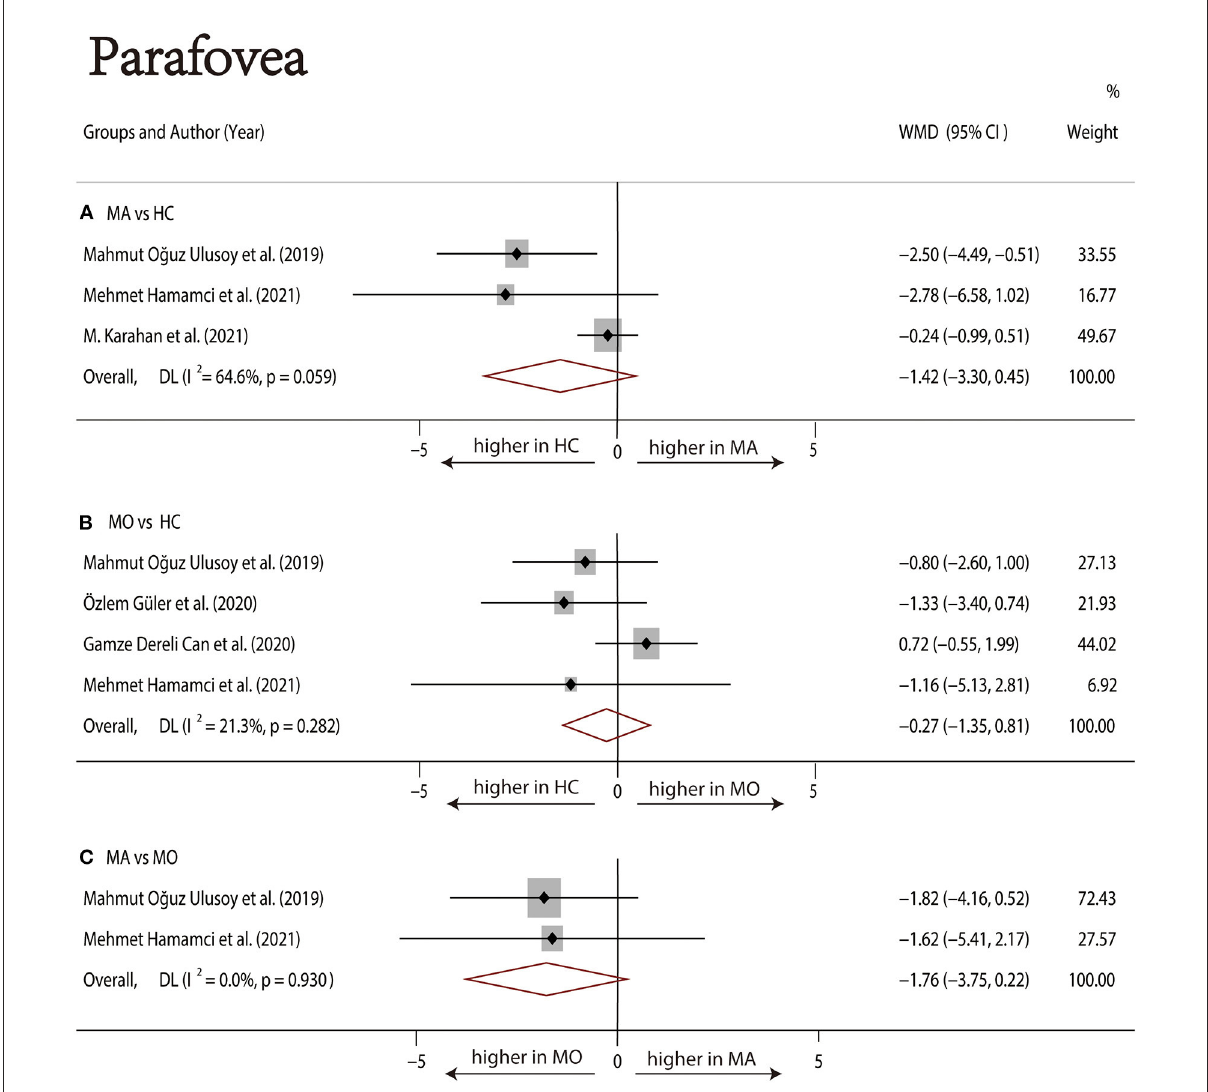
FIGURE5 Forest plot of WMD of the parafoveal SCP VD. (A) Parafoveal VD comparison of MA and HC; (B) parafoveal VD comparison of MO and HC; (C) parafoveal VD comparison of MA and MO.